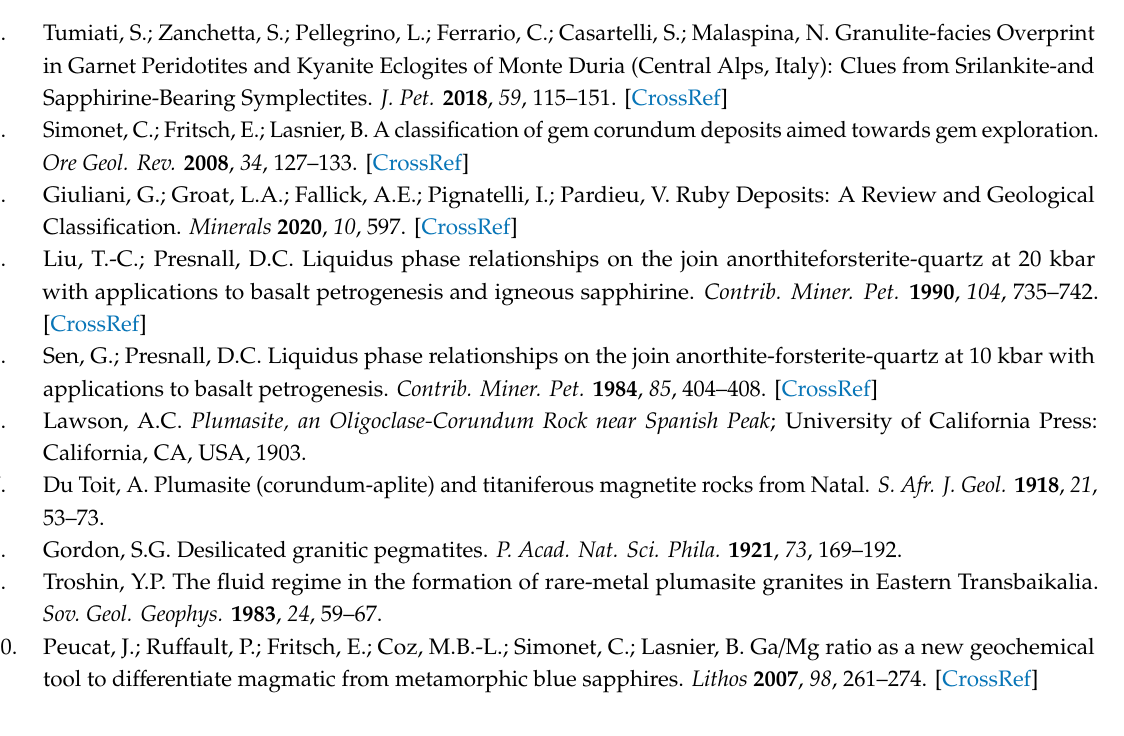
Table S1. List of analyses made on SB09 and SB08 samples. Table S2. Mineral compositions based on EMPA analyses for both felsic dykes. Table S3. LA-ICP-MS U / Pb data of zircon grains for SB09. Table S4. LA-ICP-MS U / Pb data of zircon grains for SB08. Table S5. LA-ICP-MS trace elements of zircon grains for SB09. Table S6. LA-ICP-MS trace elements of zircon grains for SB08. Table S7. LA–ICP-(MC)-MS Lu / Hf composition of zircon grains for SB09 and SB08. Figure S1. Ternary composition diagram for micas showing the composition of biotite. Red squares show the composition of biotite for SB09 felsic dyke and green squares show the composition of biotite for host gabbro of the SB08 dyke. The pink and orange squares are the composition of biotite and siderophyllite reported in the Handbook of Mineralogy [149]. Figure S2. (a,b) CL and backscattered electron (BSE) images for a zircon grain (SB09) showing internal features (zoning and inclusions) (c,d) RGB images obtained from X-ray maps showing the rich Y, U, Si, P phases / domains included in the zircon grain. (e,f) CL and BSE images for a zircon grain (SB08) showing internal features (zoning and inclusions) (g,h) RGB images obtained from X-ray maps showing the rich Y, U, Si, P phases / domains included in the zircon grain. Figure S3. Chondrite-normalized REE patterns (averages) of zircons from felsic dyke (SB09 and SB08) and from di ff erent magmatic rock types reported in Belusova et al. [68]. Normalization values are from McDonough and Sun